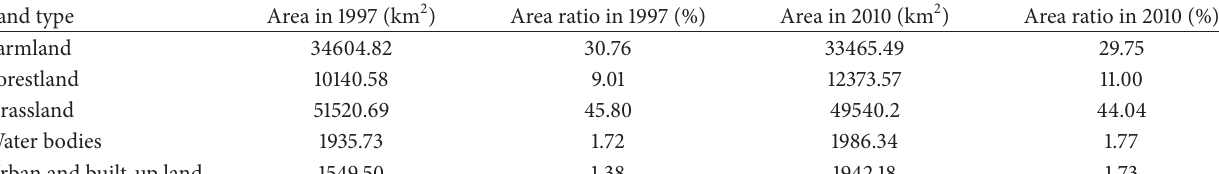
Table 2: Changes in land-cover area on the northern Loess Plateau region between 1997 and 2010.